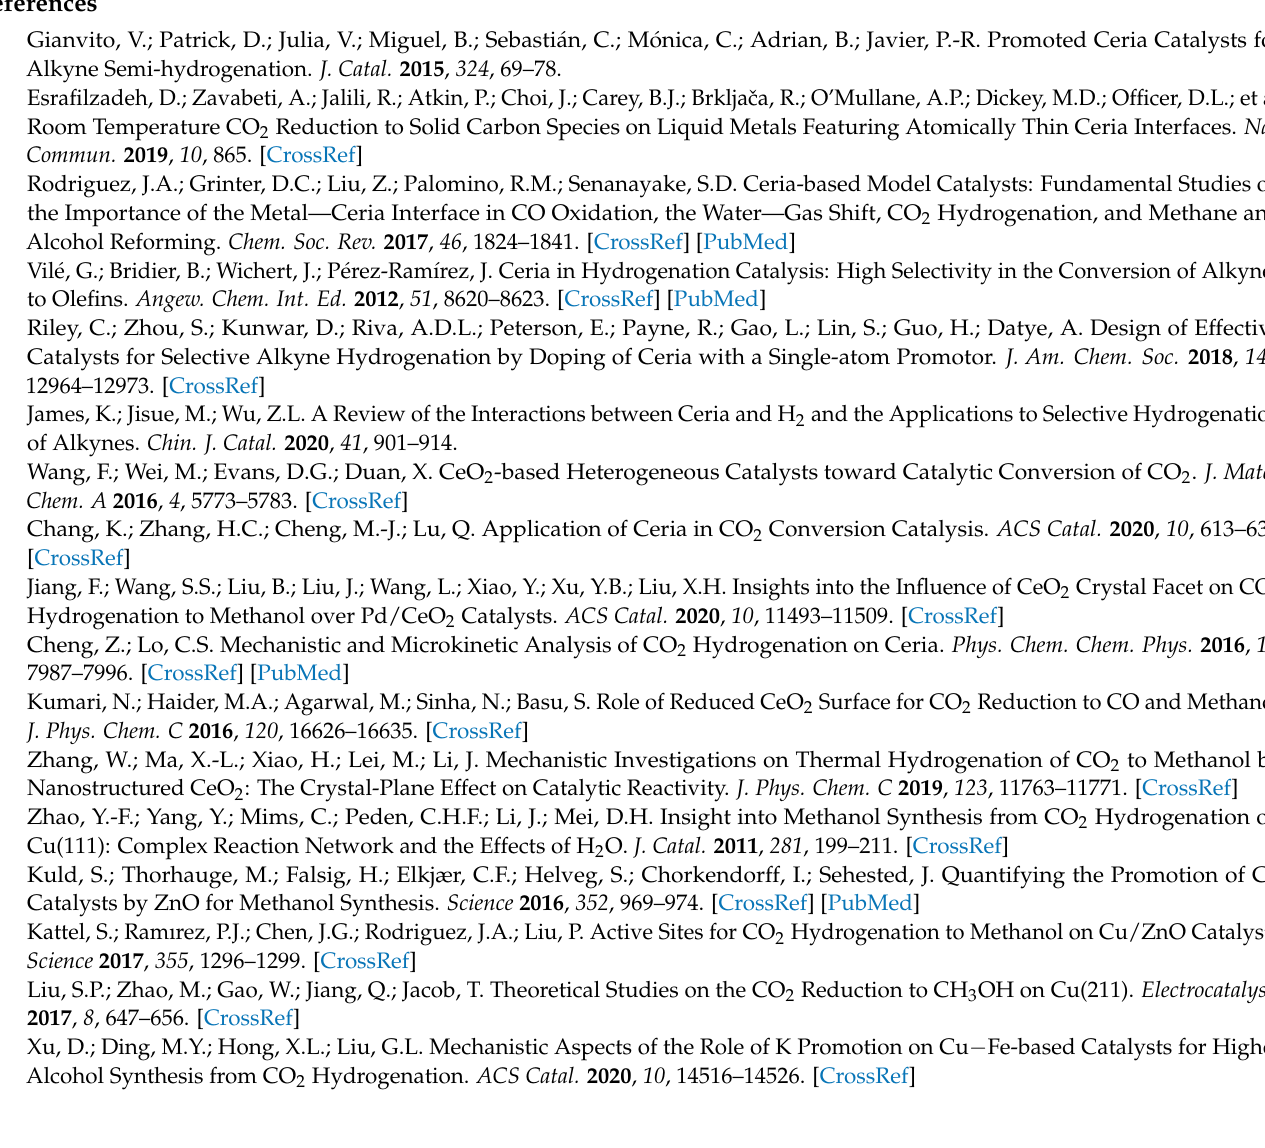
of H 2 adsorption and dissociation on the CeO 2 (111) surface. Figure S5: Calculated structures of H 2 adsorption and dissociation on the Cu/CeO 2 (111) surface. Figure S6: Calculated structures of H 2 adsorption and dissociation on the Cu/CeO 2 (111)-O V surface. Crystal Reduction Potential (Vr). Figure S7: Calculated structures of CO 2 hydrogenation on the CeO 2 (111) surface. Figure S8: Calculated structures of CO 2 hydrogenation on the Cu/CeO 2 (111) surface. References [27,38,57] are cited in the Supplementary